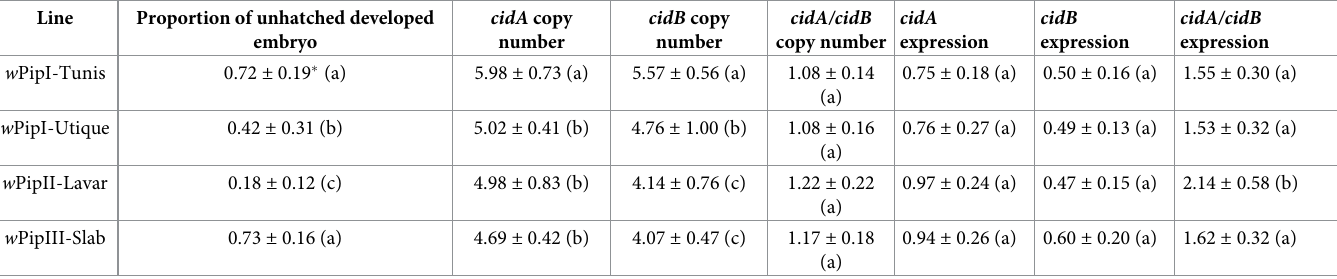
Table 1. Males with different mod profiles: Proportions of unhatched developed embryos, cidA - cidB copy number and expression. Line Proportion of unhatched developed